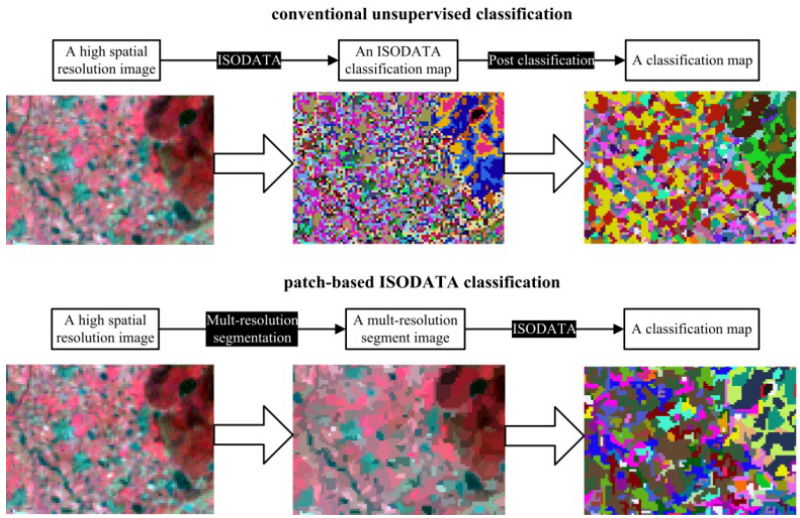
Figure 1. The processes of different classification